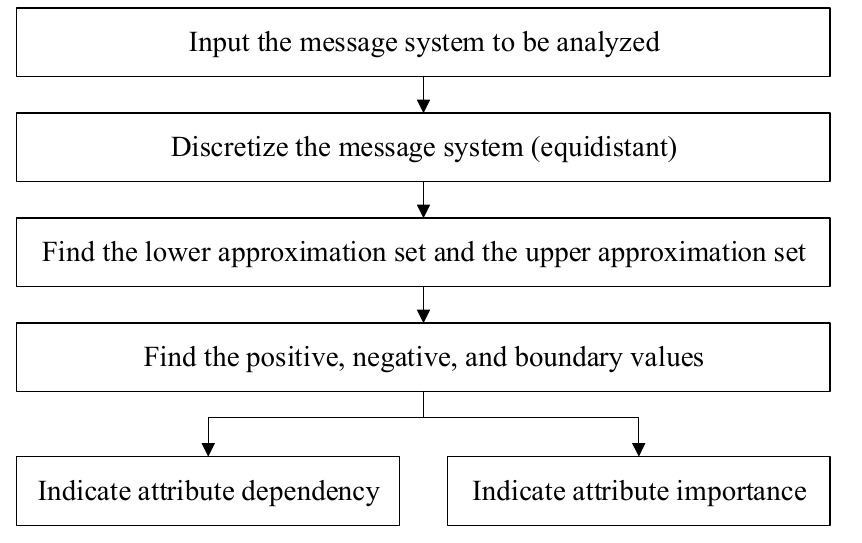
Figure 2. Block of the analytical steps used in the rough set employed in this study.